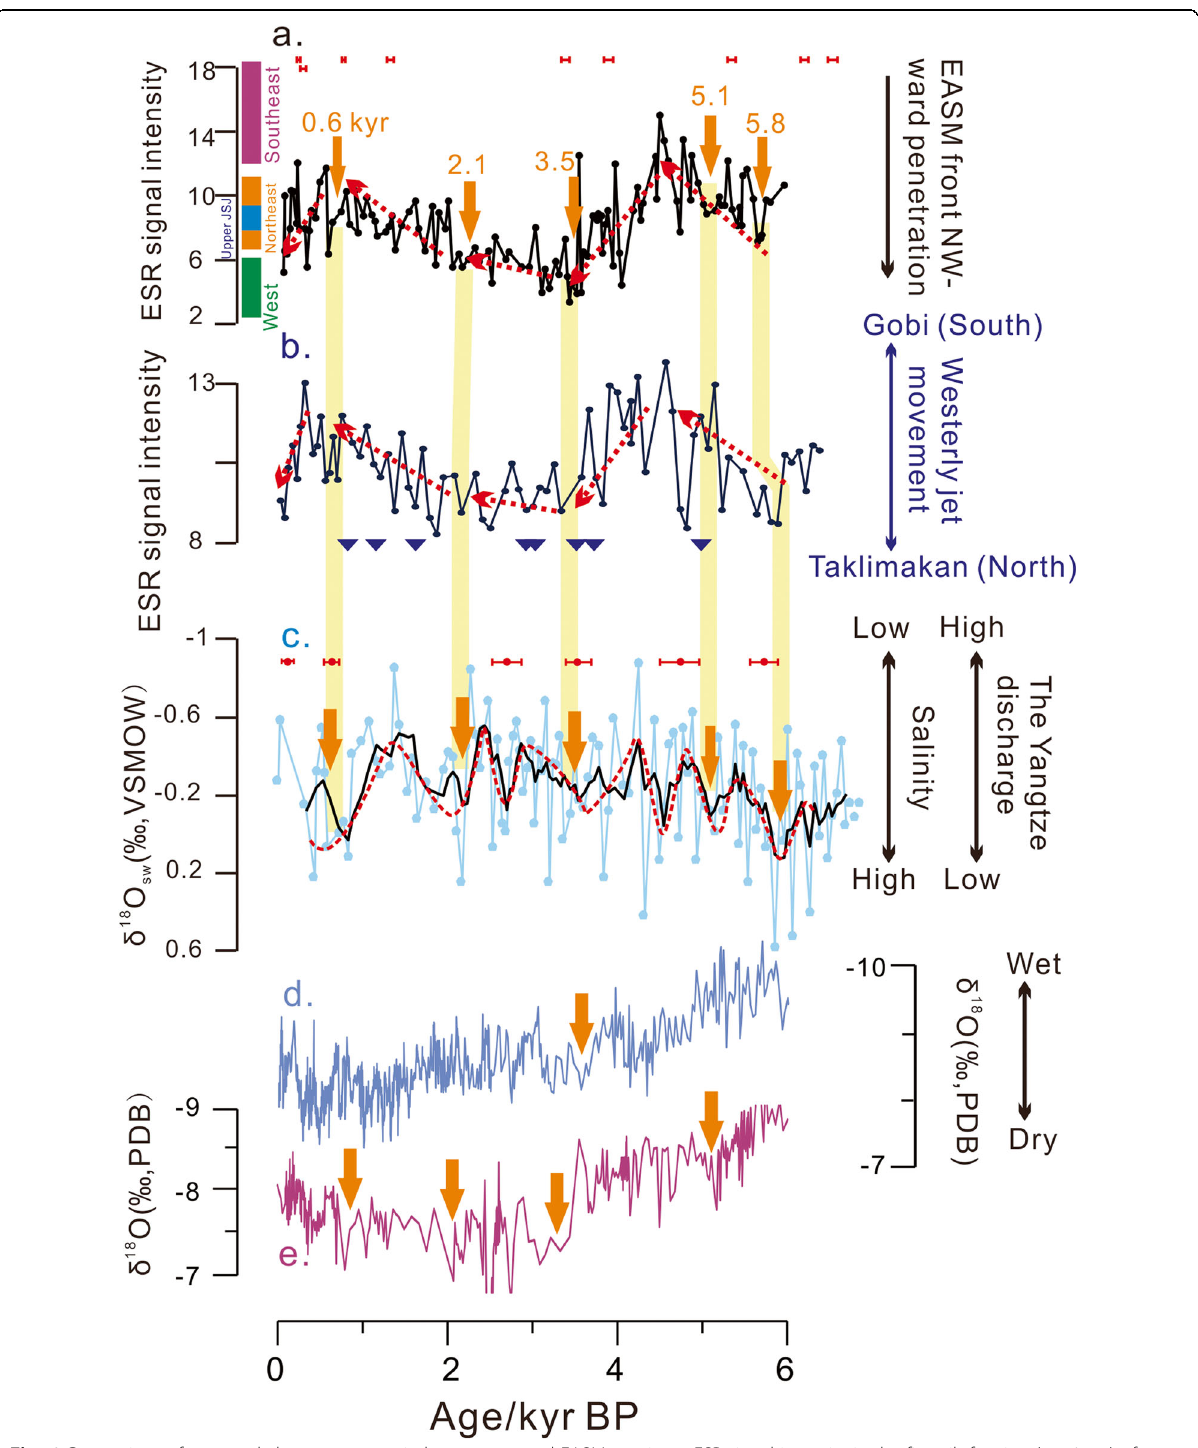
Fig. 6 Comparison of temporal change patterns in between several EASM proxies. a ESR signal intensity in the fine silt fraction (4 – 16 μ m) of MD06-3040 core sediments (this study). b ESR signal intensity in the fine silt fraction (4 – 20 μ m) of D-GC-6 core sediments (Nagashima et al. 2013). c δ 18 O sw , an indicator of the sea surface salinity (SSS), at the KY07-04-01 site in the northern ECS during the Holocene based on paired analyses of Mg/Ca and δ 18 O of planktonic foraminifera (Kubota et al. 2010, 2015), where the black thin line represents the 3-point moving average. d δ 18 O record of a stalagmite from Heshang Cave (Hu et al. 2008). e δ 18 O record of a stalagmite from Dongge Cave D4 (Dykoski et al. 2005). The calibrated 14 C dates of the MD06-3040 and KY07-04-01 cores are presented with 2 σ errors on the top of the